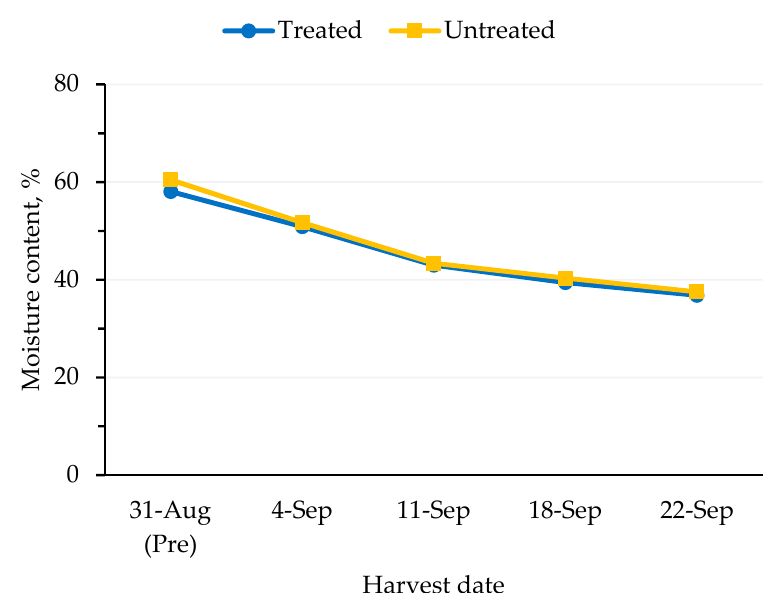
Figure 3. Mean moisture content in percentage at each harvest date for corn hybrid seeds harvested at different harvest dates in 2015. 31-Aug (Pre) refers to harvest before defoliant application; all other harvest dates are post-defoliant application. Aug and Sep indicate the months of August and September. The blue line represents seed moisture values for seed harvested from plants treated with a defoliant; the yellow line represents seed moisture values for seed harvested from the untreated control plants. Means are not significantly different ( p ≤ 0.05).